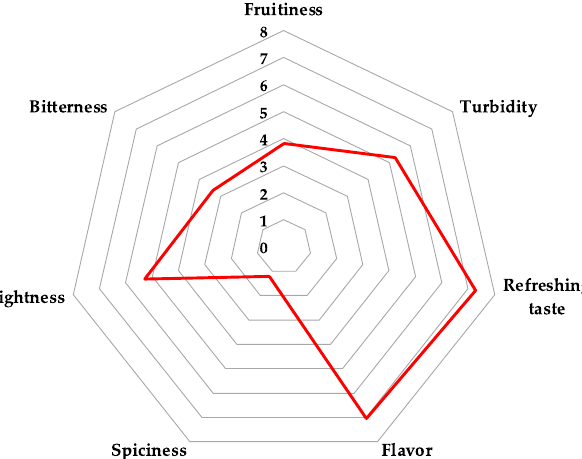
Figure 3. Evaluation of some attributes of the beer made with P. kudriavzevii 4A. In the second sensory test, the judges compared various a tt ributes of two Belgian- style pale ales: the present product and a commercial reference sample elaborated with S.